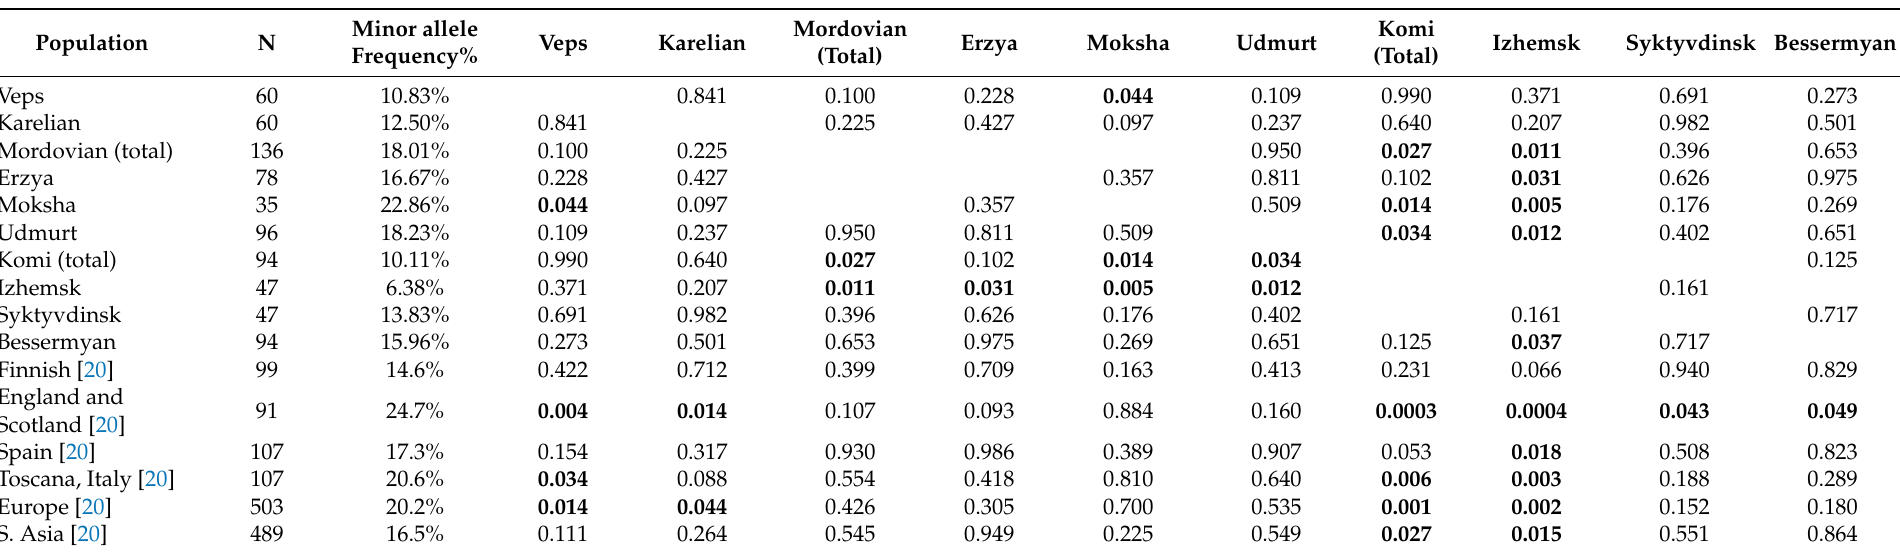
Table 5. Frequencies of the minor allele rs1065852 of the CYP2D6 gene in the studied samples of Finno-Permic peoples, as well as in some populations of the